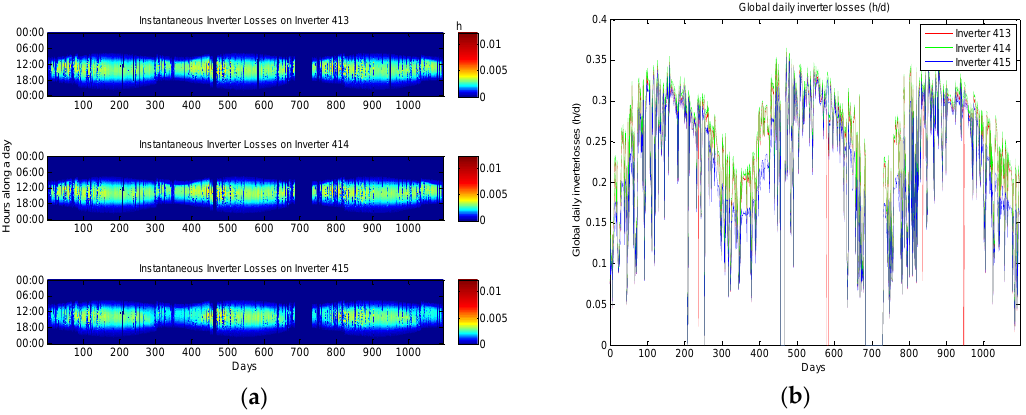
Figure 14. Inverter losses, from 1 January 2011 to 31 December 2013: ( a ) instantaneous values, during 24 h a day; and ( b ) total daily values.